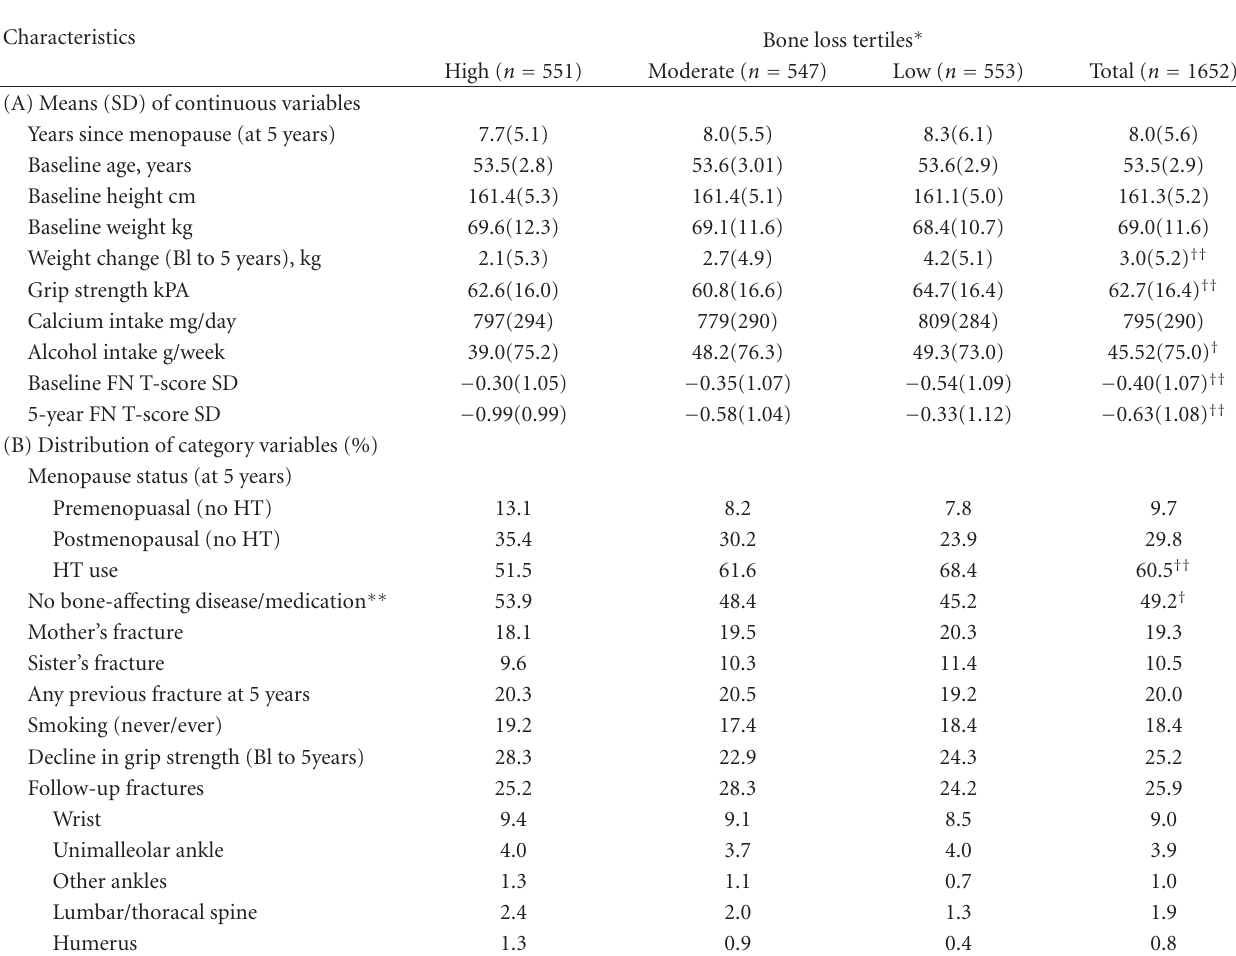
Table 1: Characteristics according to study groups (annual bone loss tertiles, n =